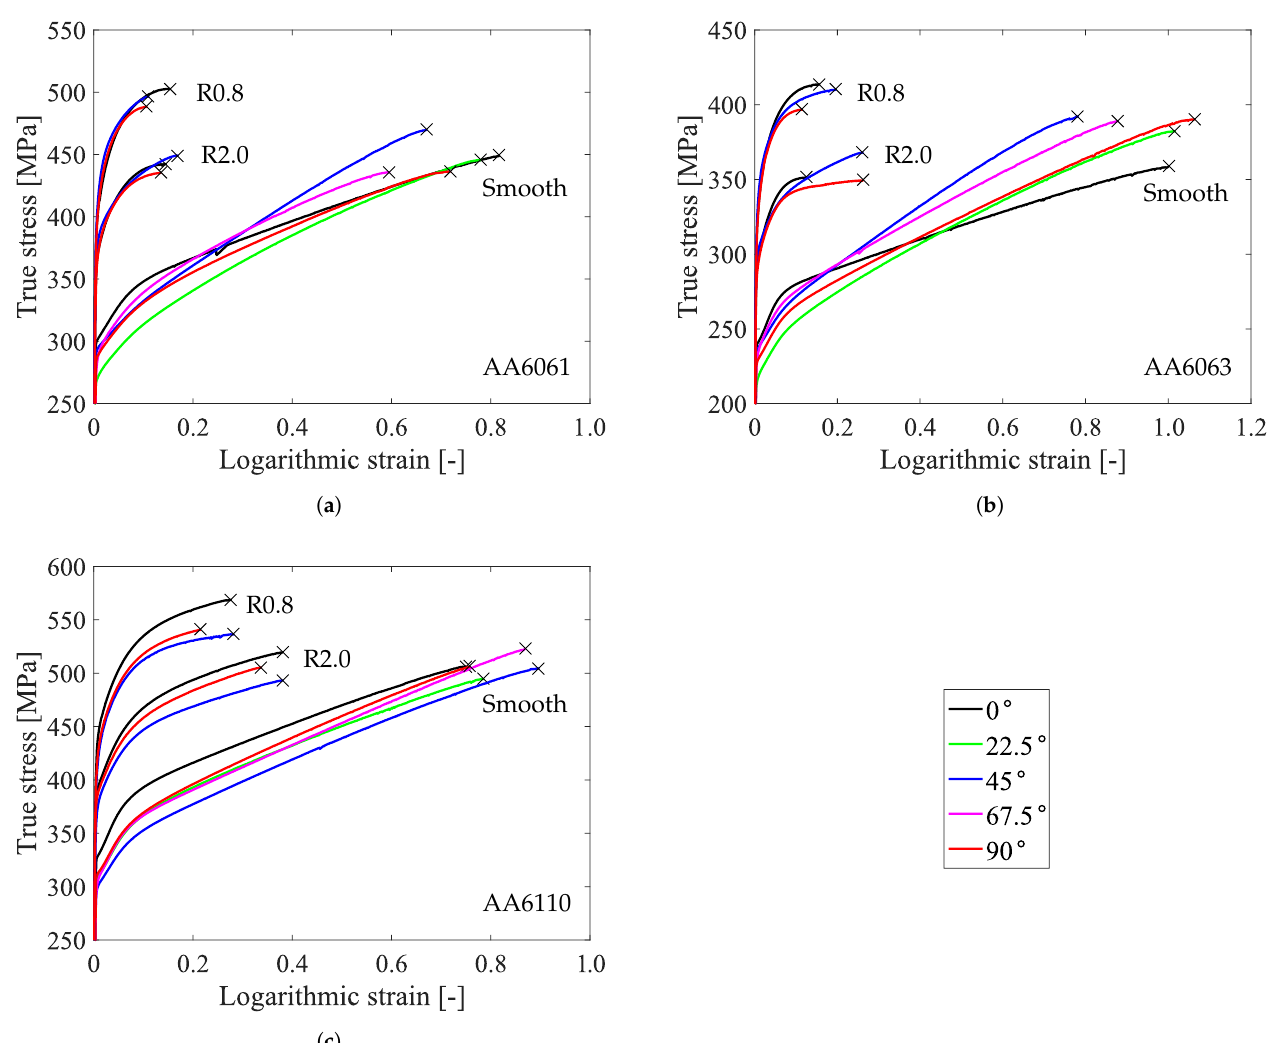
Figure 7. Representative stress-strain curves for all tested combinations of tensile direction and specimen geometry of alloy ( a ) AA6061, ( b ) AA6063 and ( c ) AA6110. The × marks failure at maximum true